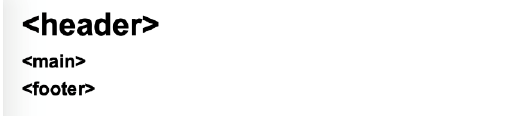
Figure 4. HTML code generated for the default layout functions inplementaiton